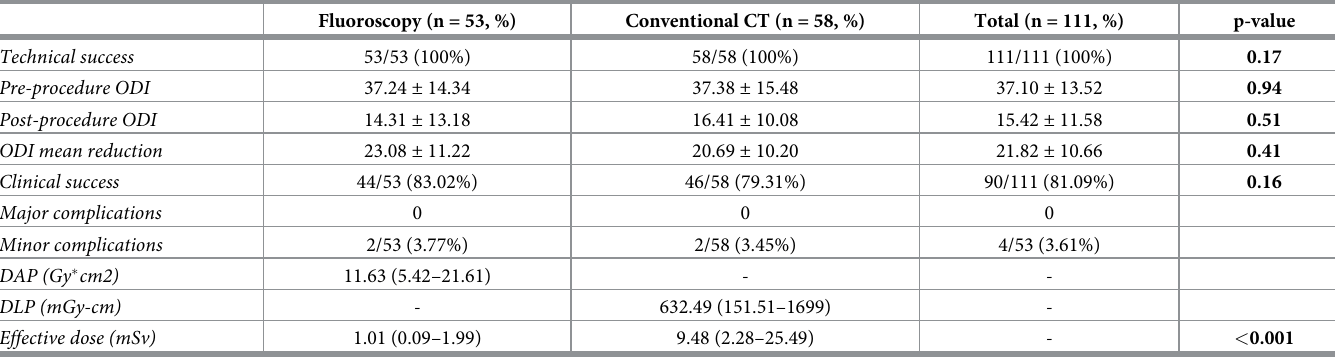
Table 3. Outcomes sorted by guidance technique (Fluoroscopy, conventional